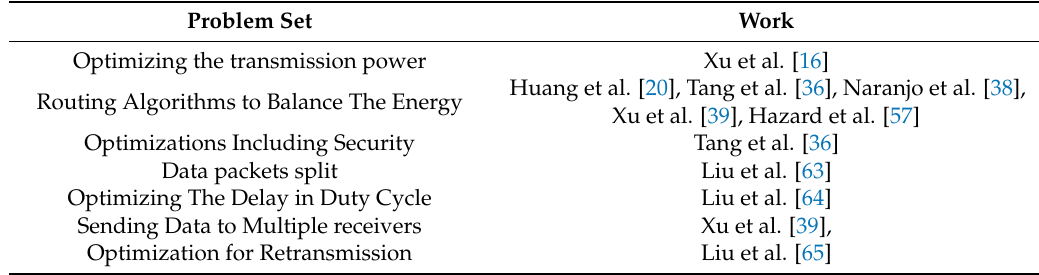
Table 2. The references summary of research on delay